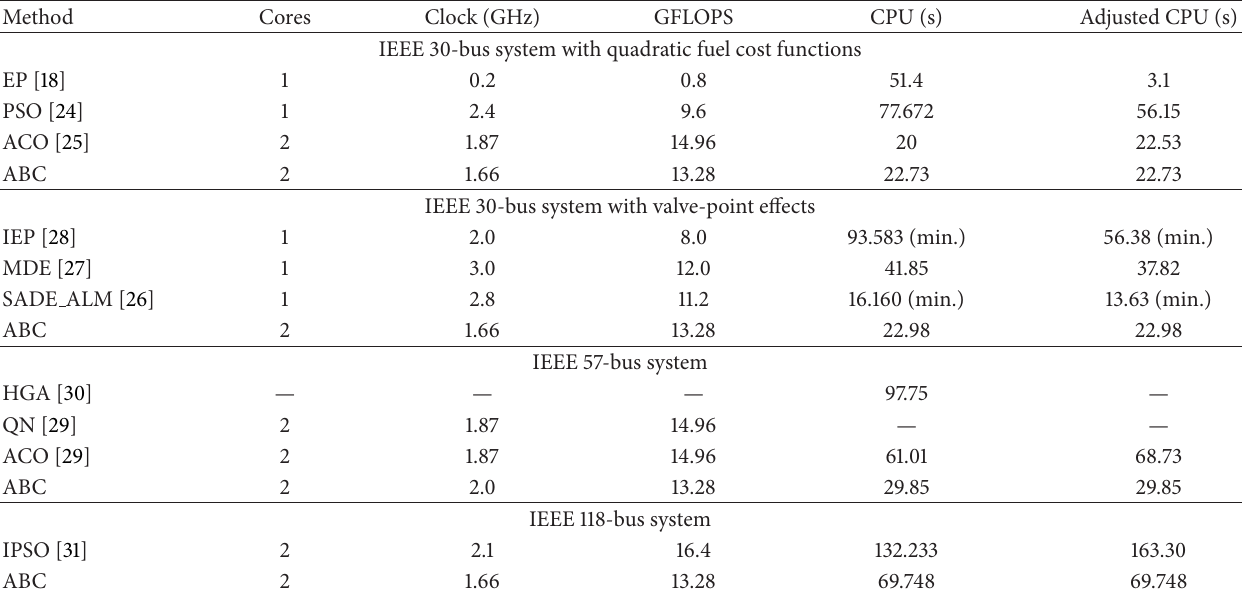
Table 5: Adjusted CPU times for different test systems.